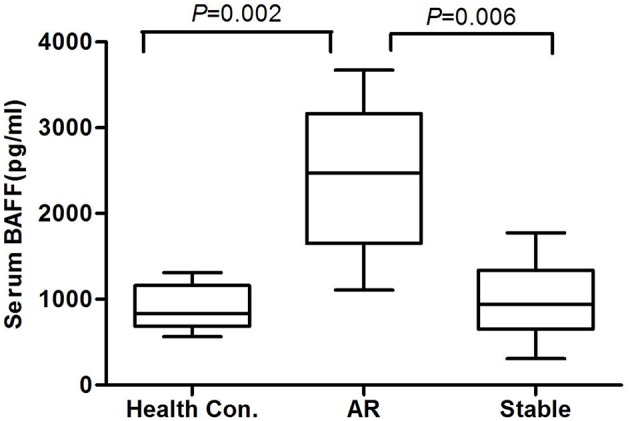
The serum BAFF levels at the time of acute rejection in different groups. The serum BAFF level was 2426.19 ± 892.19 pg/mL (95% confidence interval: 1489.89~3362.49 pg/ml) at the time of acute rejection, significantly higher than that in the stable renal function group (988.17 ± 485.63 pg/mL, P < 0.05) and healthy controls (898.10 ± 269.74 pg/mL, P < 0.05).